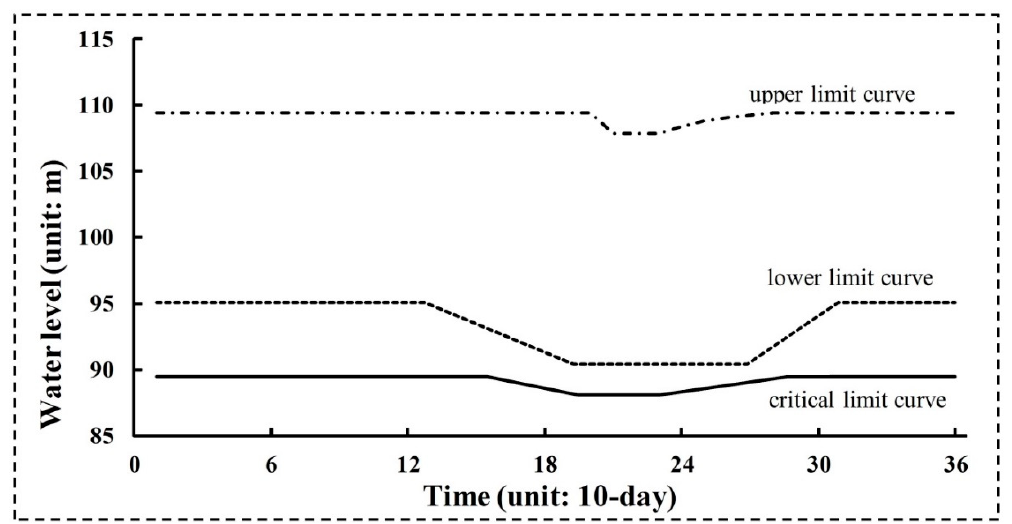
Figure 12. Optimal reservoir operating rule curves (RORCs) with 0.3958 flow regime alteration under FP scenario optimized by NGA.